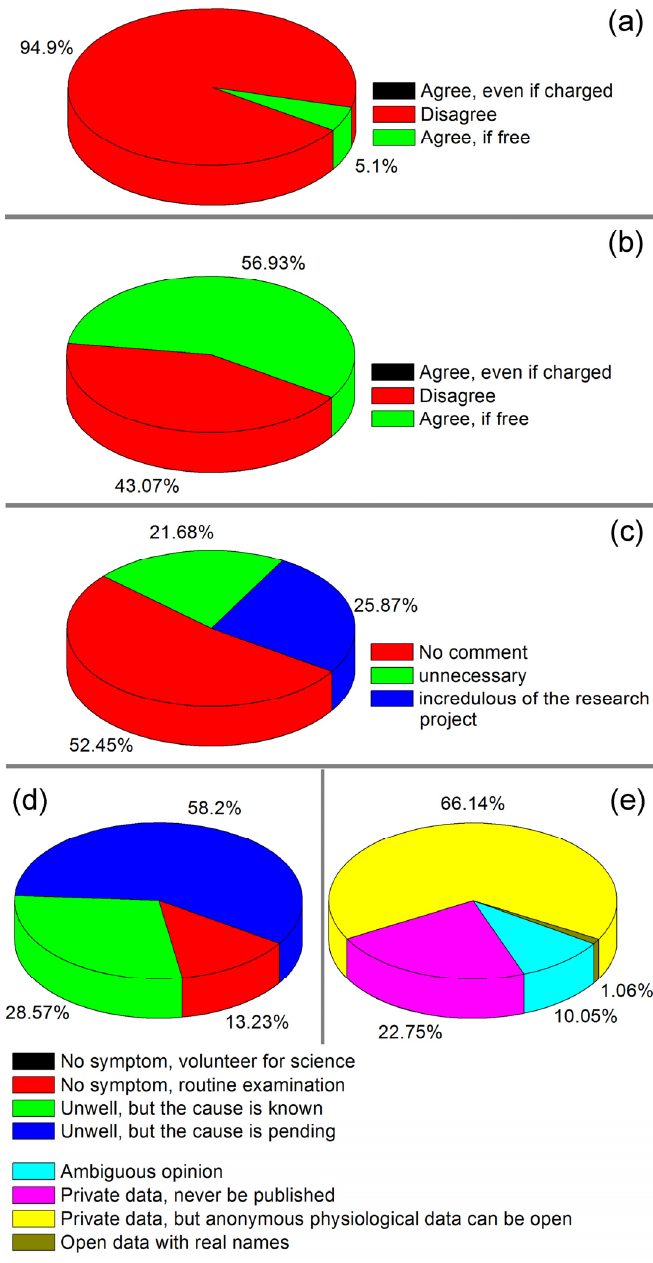
Figure 6. Survey study in the data acquisition process of HSMPD [34]. ( a ) The survey result on the attitudes towards HSMPD among the people far away from